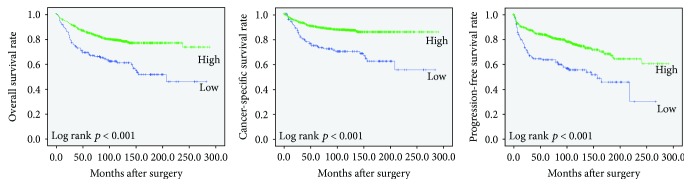
Kaplan-Meier curves for impact of the CASZ1 expression on overall survival, cancer-specific survival, and progression-free survival.